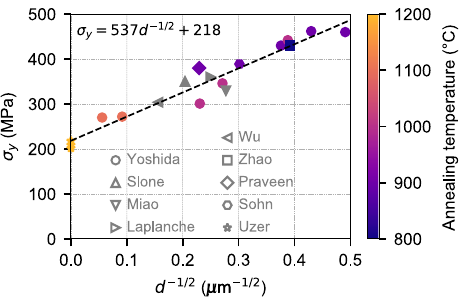
Fig. 1 Aggregated literature data on yield strength versus inverse square- root of grain size in NiCoCr (Hall – Petch scaling). All samples are single- phase fcc with grain size d ≥ 4 μ m (excluding twin boundaries) and tested in tension at room temperature and strain rate 0.5 – 1 × 10 − 3 s − 1 . Samples indicated in color were water-quenched after the fi nal heat treatment, with the color indicating the heat treatment temperature. Samples in gray were air-cooled after heat treatment. A best- fi t linear regression to all of the data is shown, and differences in heat treatment and/or cooling method do not give rise to measurable differences in strength. The strength obtained by extrapolation to in fi nite grain size agrees well with the recent single-crystal experiments (data of Uzer et al. 18